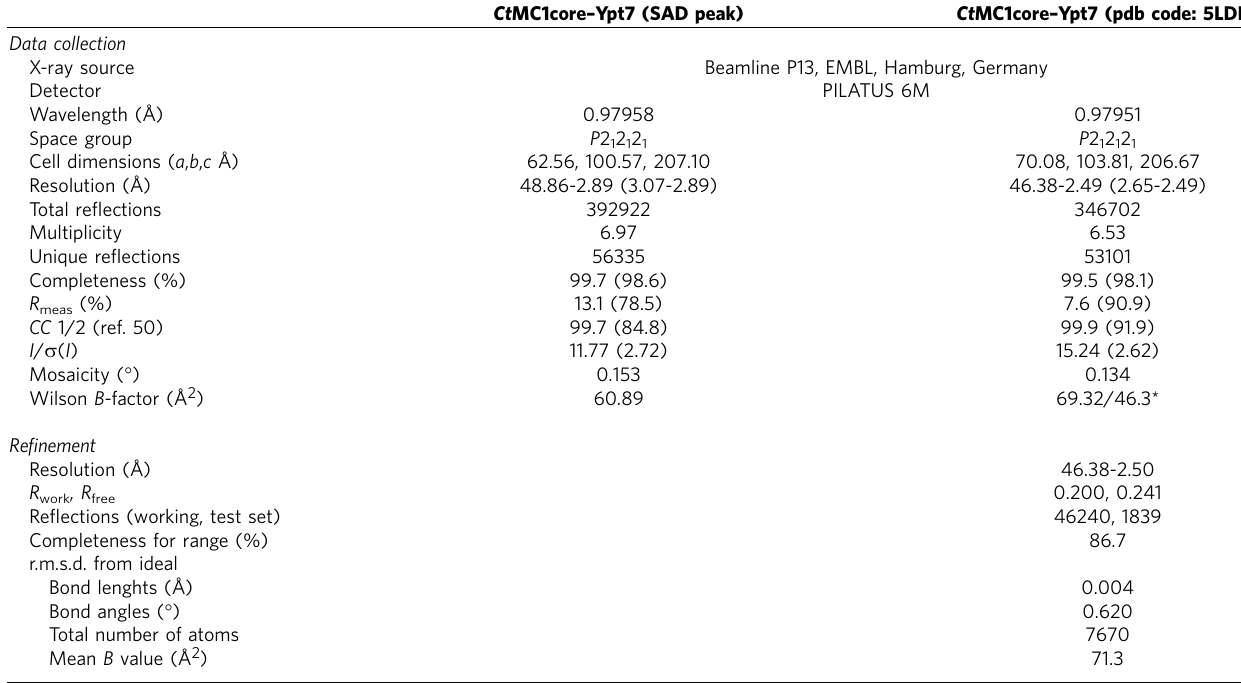
Ct MC1core–Ypt7 (SAD peak) Ct MC1core–Ypt7 (pdb code: 5LDD)